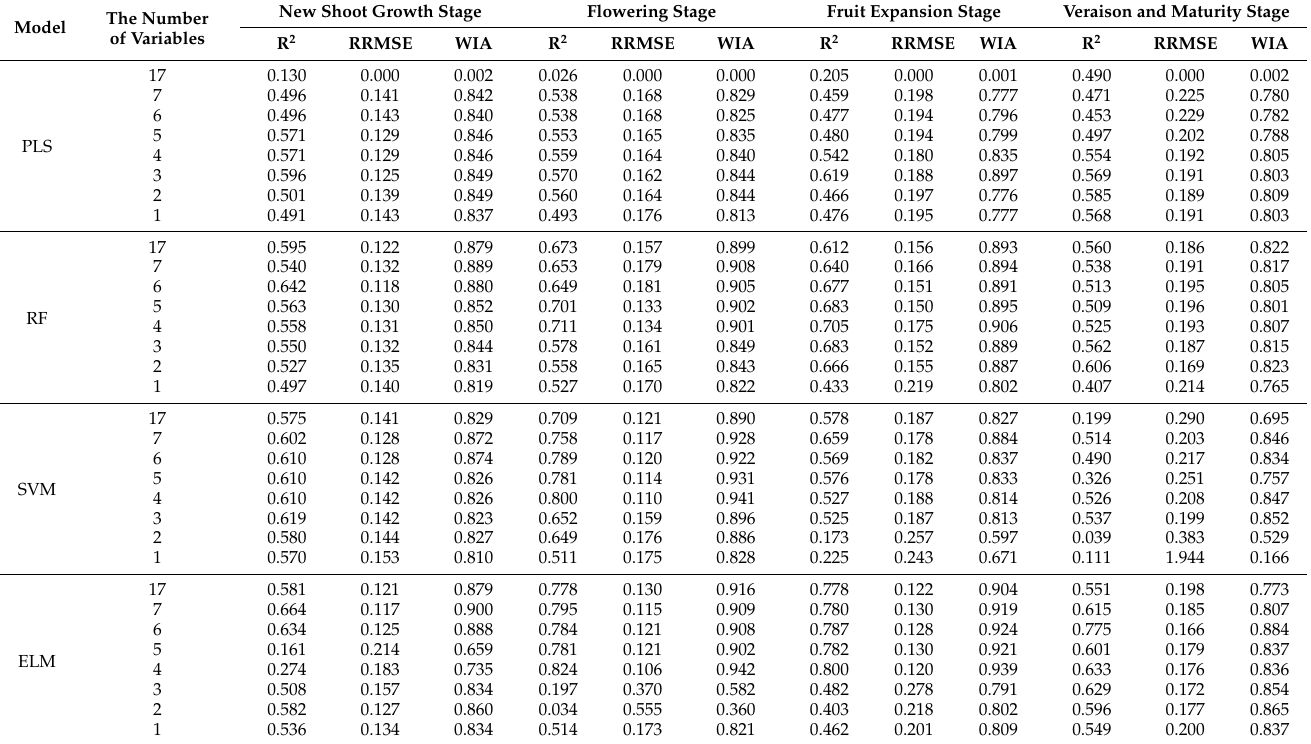
Table 6. Results analysis of LPC prediction model constructed based on different spectral